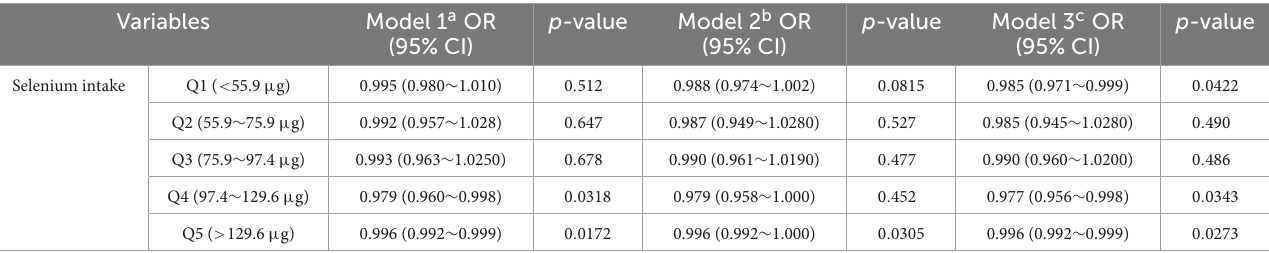
TABLE 3 Association between selenium intake levels and cataract in different quintiles.